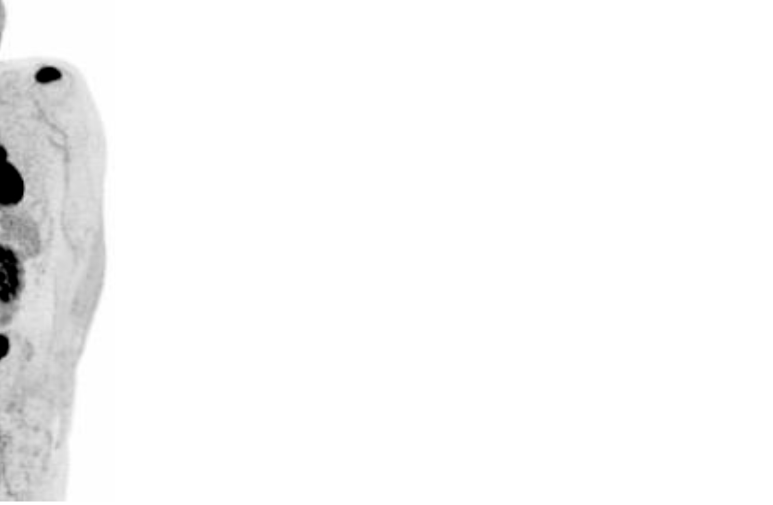
Figure 5. Advanced radioiodine-refractory and [ 18 F]FDG-avid metastatic thyroid carcinoma involv- ing the thyroid “in toto” with multiple metastases (lymph nodes, lung, liver, kidney, and bone).